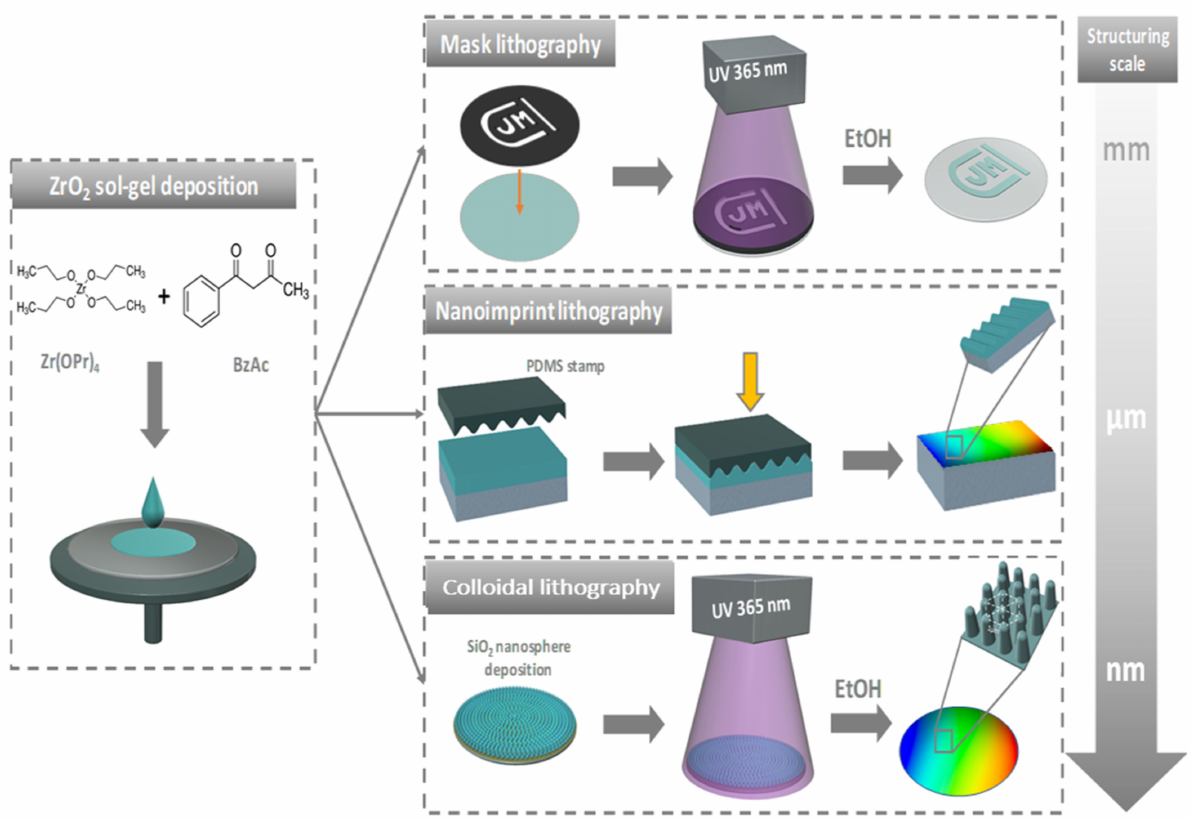
Figure 7. Illustration of the different methods of ZrO 2 sol-gel